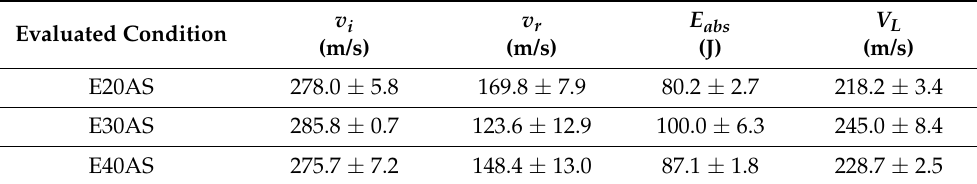
Table 5. Residual velocity ballistic test results for epoxy composites reinforced with 20, 30, and 40 vol% of arapaima scales against 0.22